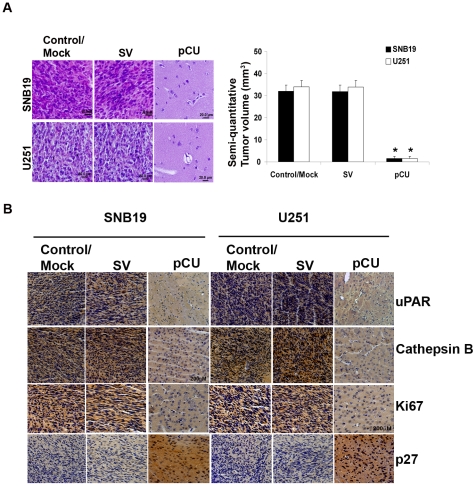

In vivo inhibition of tumor growth.Stereotactic implantation of SNB19 and U251 (1×105) tumor cells was performed and, after one week, PBS (mock), SV or pCU was injected into the brain using an Alzet mini osmotic pump. Five animals per group were used. 30 days after implantation, the animals were sacrificed, the brains were removed and fixed, and paraffin sections were prepared. A. Hematoxylin and eosin staining of tissue sections to visualize tumor cells and to examine tumor volumes. Bar: 20 µM (*p<0.01) B. Immunohistochemical analysis of cathepsin B, uPAR, Ki67 and p27Kip1 in paraffin embedded tissue sections. Bar: 200 µM.